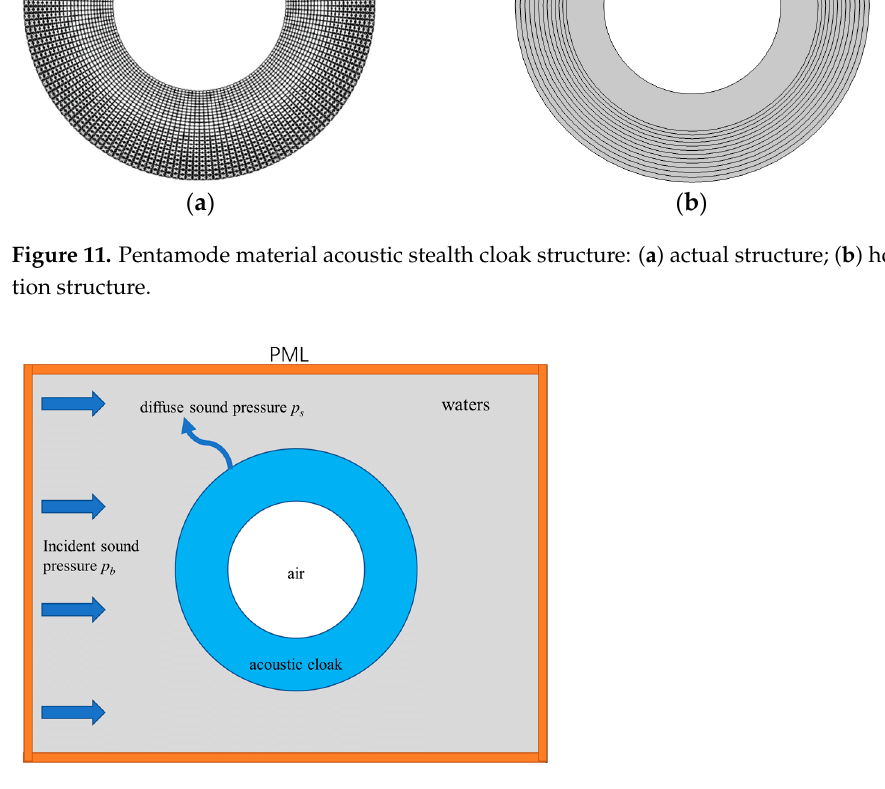
Figure 12. Schematic diagram of the acoustic scattering simulation model of the acoustic cloak. When / 0.8 a λ=